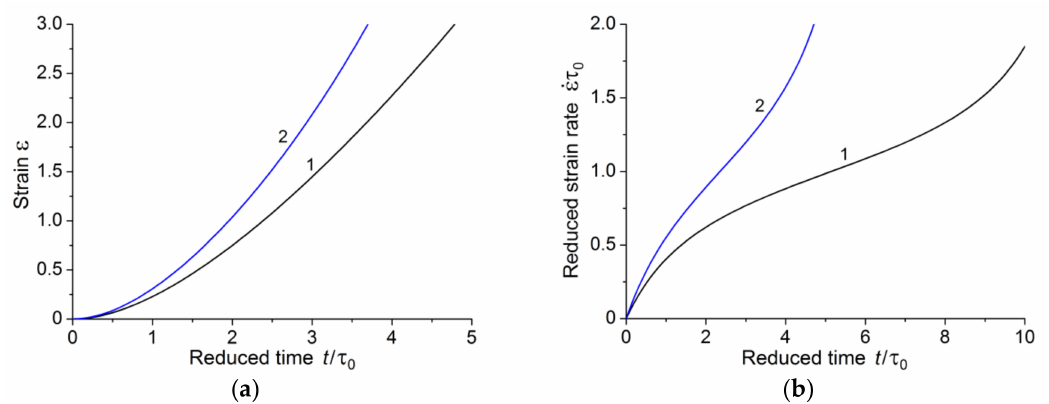
. ξ = ( B / η ) . ε ( b ) with respect to